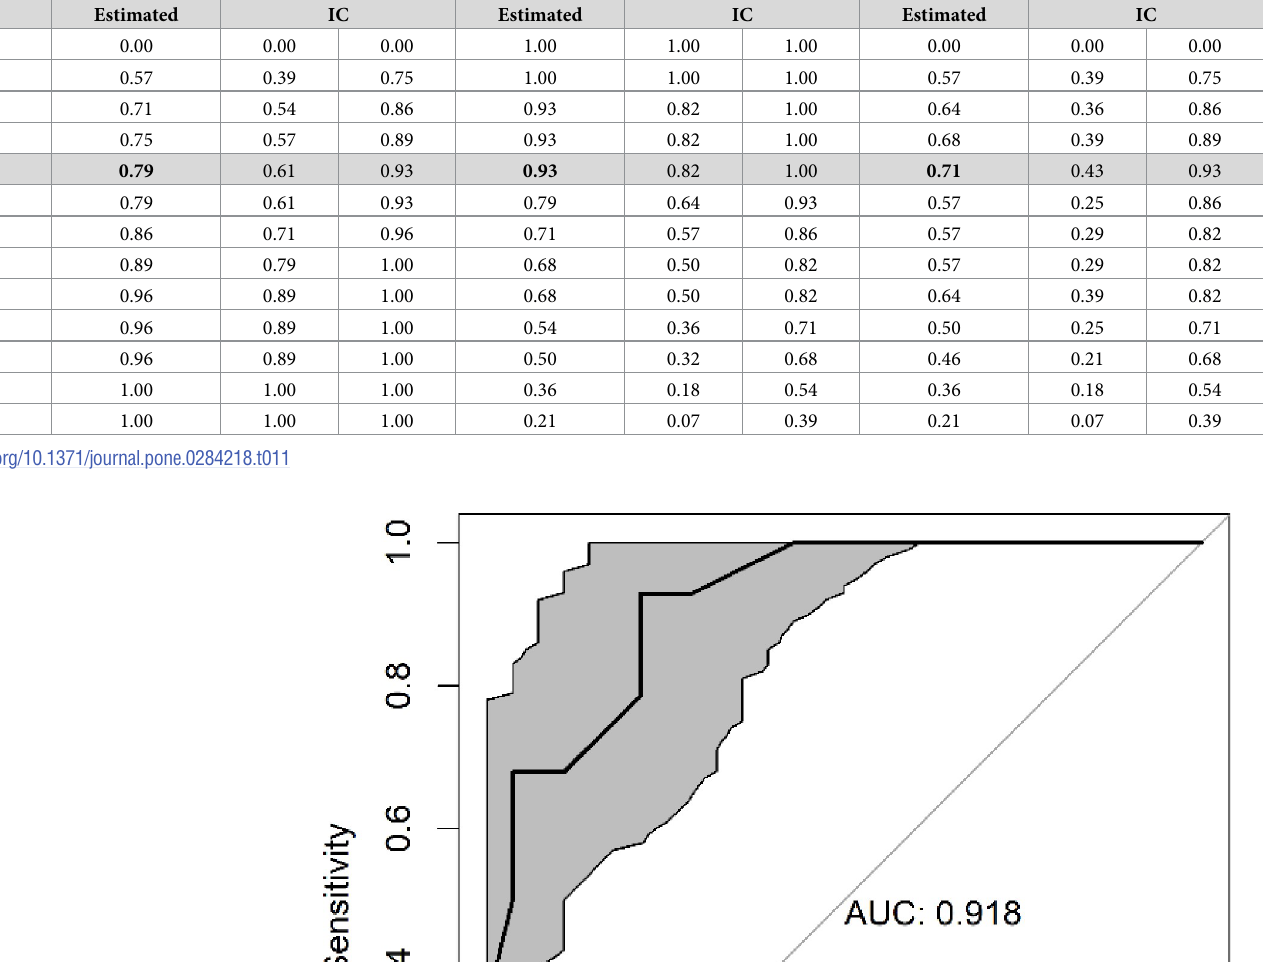
Table 11. Specificity, sensitivity, and Youden index of optimal cut-off for UPAPS. UPAPS